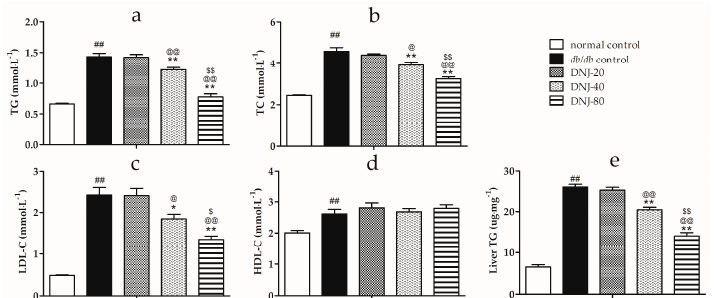
Figure 2. Effect of DNJ on the levels of serum triglyceride (TG) ( a ); total cholesterol (TC) ( b ); low density lipoprotein cholesterol (LDL-C) ( c ); high density lipoprotein cholesterol (HDL-C) ( d ) and liver TG content ( e ) in db/db mice. ## p < 0.01 vs. normal control. * p < 0.05, ** p < 0.01 vs. db/db control, @ p < 0.05,